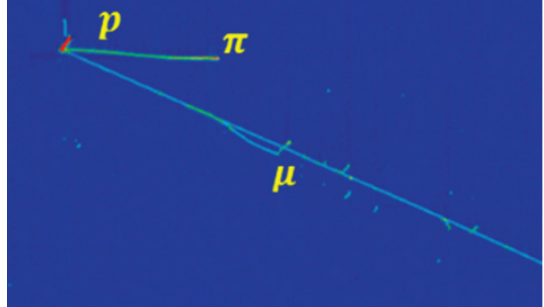
Figure 3. A charge current ν event in the µ BooNE LArTPC detector showing excellent track resolution. A low energy, ∼ 25 MeV proton, charged pion, and muon are identified. Adapted from